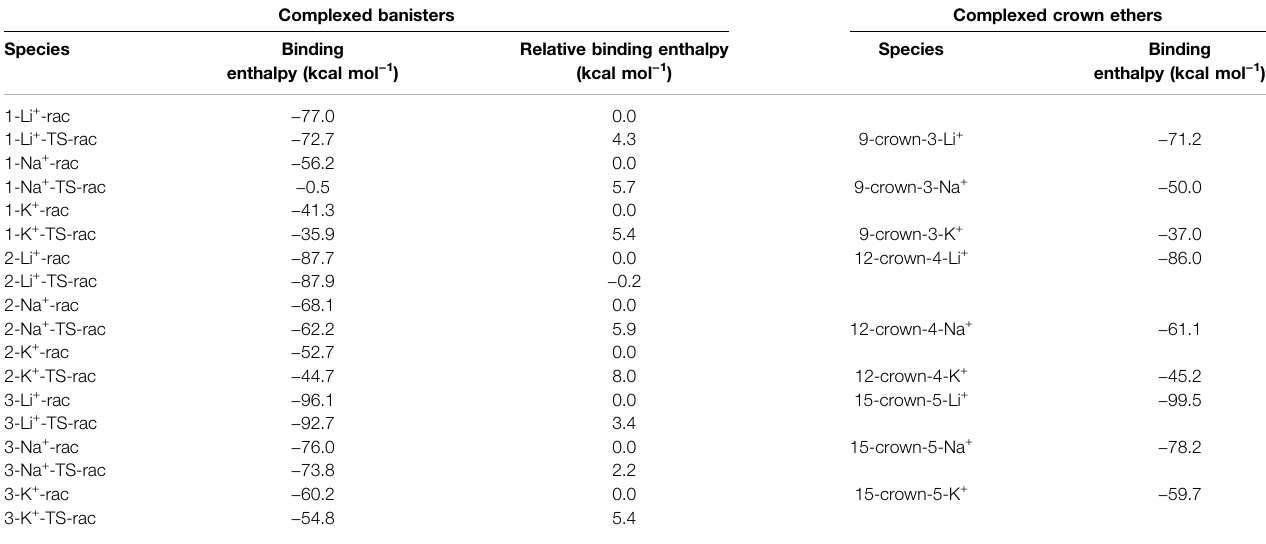
TABLE 3 | Computed binding energies for complexed banisters (left) and for the complexes of their corresponding crown ethers (right). Complexed banisters Complexed crown ethers